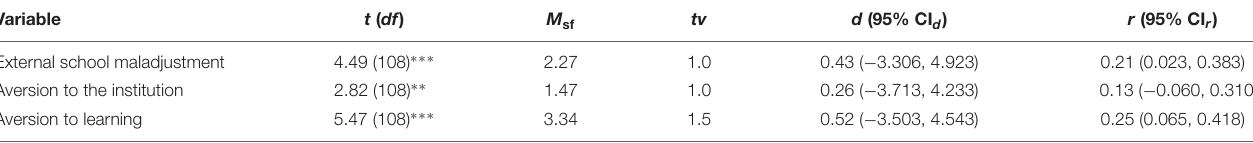
TABLE 2 | One sample t -test for the sub-dimensions of scholar maladjustment at level 1. Variable